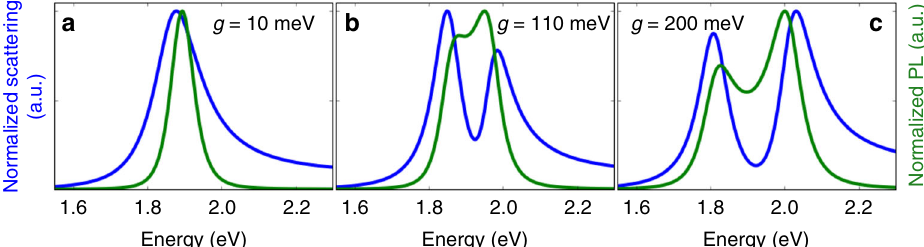
Fig. 1 Predictions for coupled quantum-dot / gap-plasmon systems in different coupling regimes. a Weak coupling, b intermediate coupling (Fano interference), c strong coupling (Rabi splitting). The predicted scattering spectra (blue) and photoluminescence spectra (green) are calculated according to analytical models using the coupling strengths shown in the